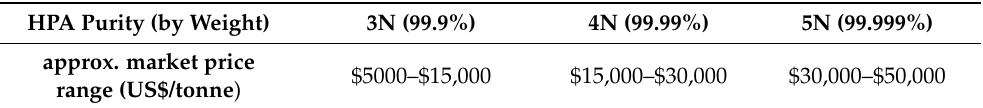
Table 1. Approximate market price for HPA by product purity. Ranges are estimated from various